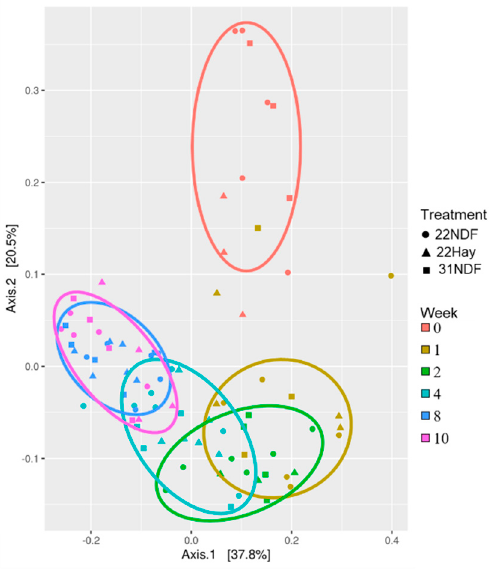
Figure 5. β -diversity of bacterial community in ruminal fluid samples in dairy calves fed different levels and sources of NDF. Multidimensional scaling (MDS) showing the weighted UniFrac distance metric; 22NDF—calves fed starter concentrate with 220 g NDF/kg; 22Hay—calves fed starter concentrate with 220 g NDF/kg and grass hay; 31NDF—calves fed starter concentrate containing 310 g